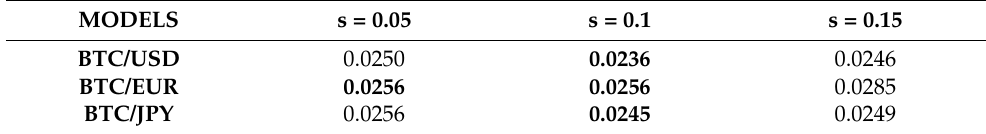
Table 12. Minimum RMSE for CMCMA model using different climb step length.